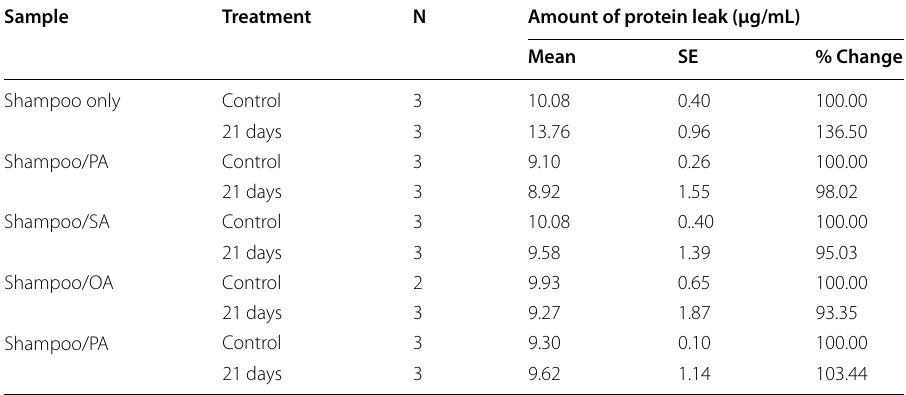
Table 18 t-test comparison of the amount of protein leak after 21 days of treatment between BH shampooed only and BH shampooed with fatty acid conditioners Variable Sample